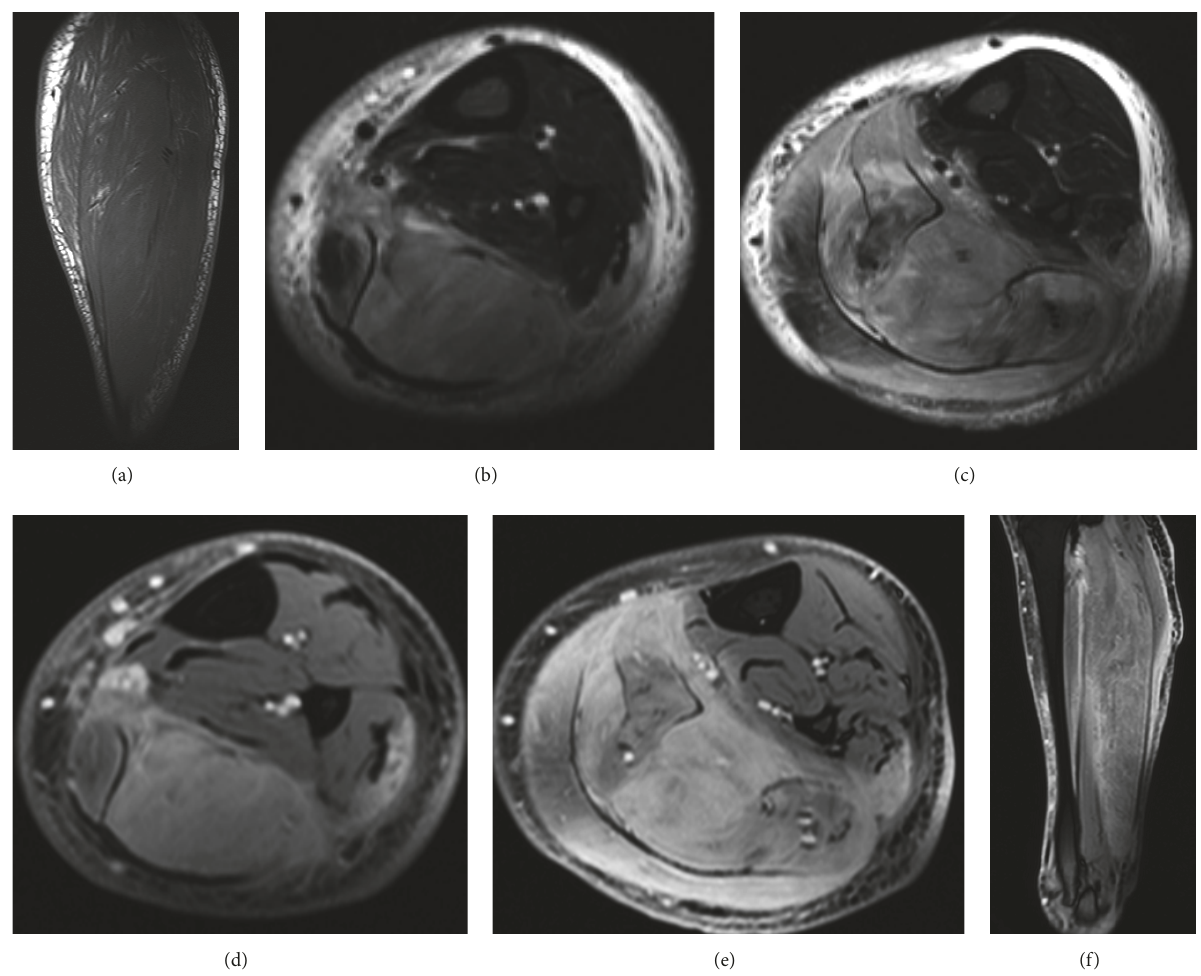
Figure 4: Sagittal T1 (a), axial STIR (b, c), axial T1 fat saturated postcontrast (d, e), and sagittal T1 fat saturated postcontrast (f) images of the involved lower leg in the 55-year-old man with HIV described in case 2. There is marked enlargement of the posterior calf muscles with effacement of the intramuscular fat. The affected muscle demonstrates T2 hyperintense signal and diffuse enhancement on postcontrast sequences. The overall findings should raise the suspicion for an infiltrative process such as lymphoma.